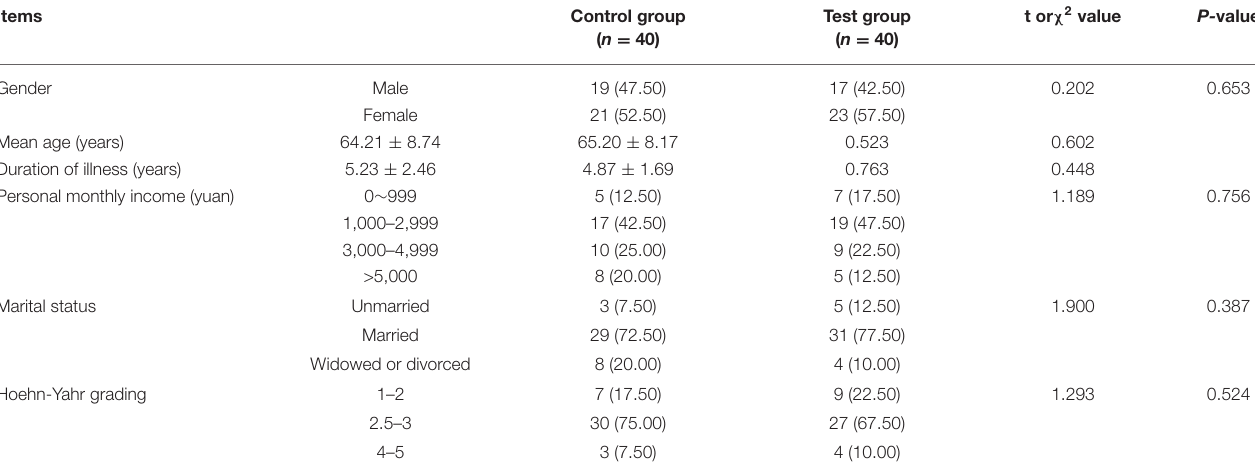
TABLE 2 | Comparison of baseline information between the two groups (%, x ±